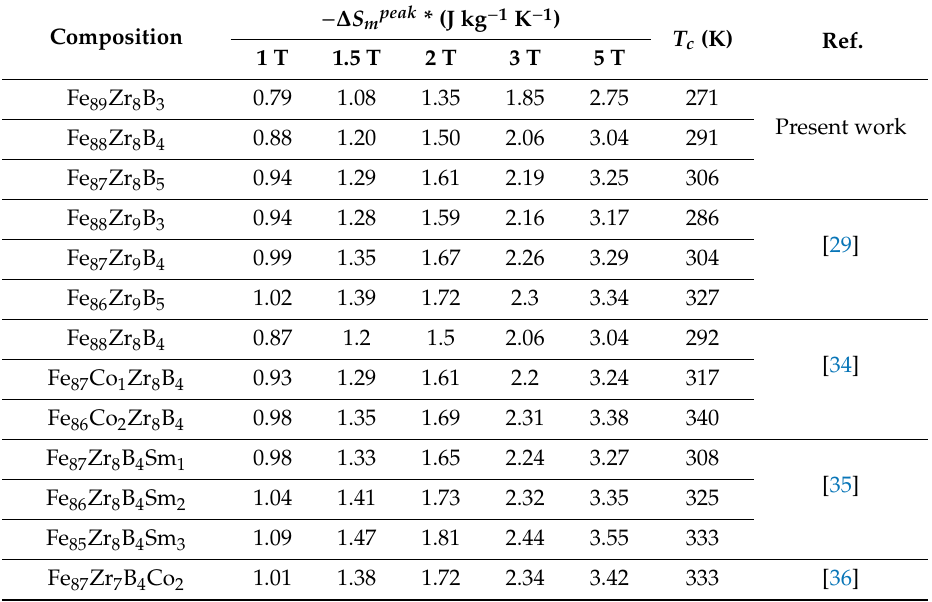
Table 1. Curie temperature, T c , and − ∆ S mpeak of the several Fe-Zr-B-based amorphous samples. Composition